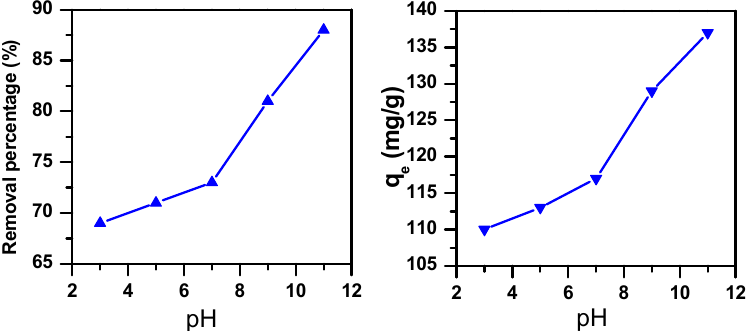
Figure 1. Removal efficiency of Fe 2 (MoO 4 ) 3 in an 80-ppm methylene blue (MB) solution as a function of pH (m ads = 0.05 g, T = 20 °C, t = 30 min).